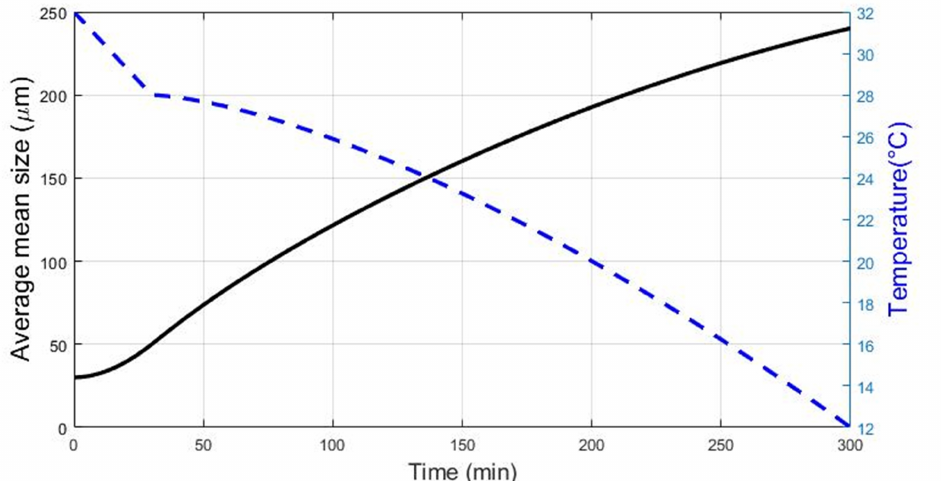
Figure 1. Desired mean size profile (black) and corresponding temperature profile (blue,